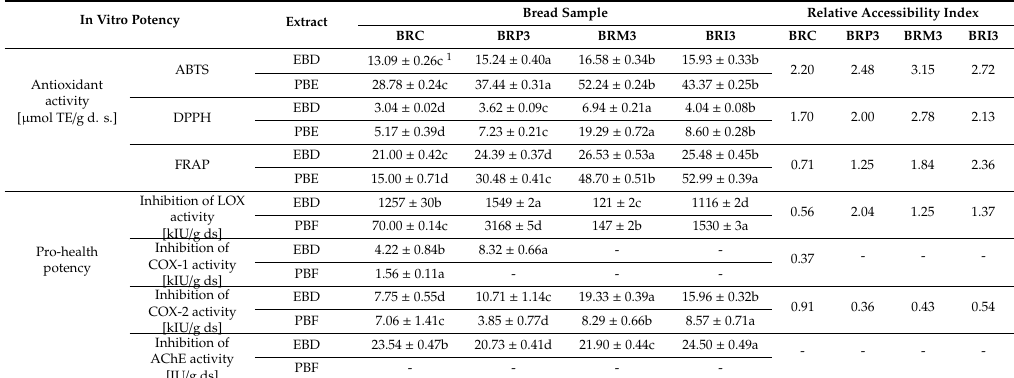
Table 5. Ability to inhibit the activity of enzymes related to metabolic syndrome. InVitroPotency Extract BreadSample